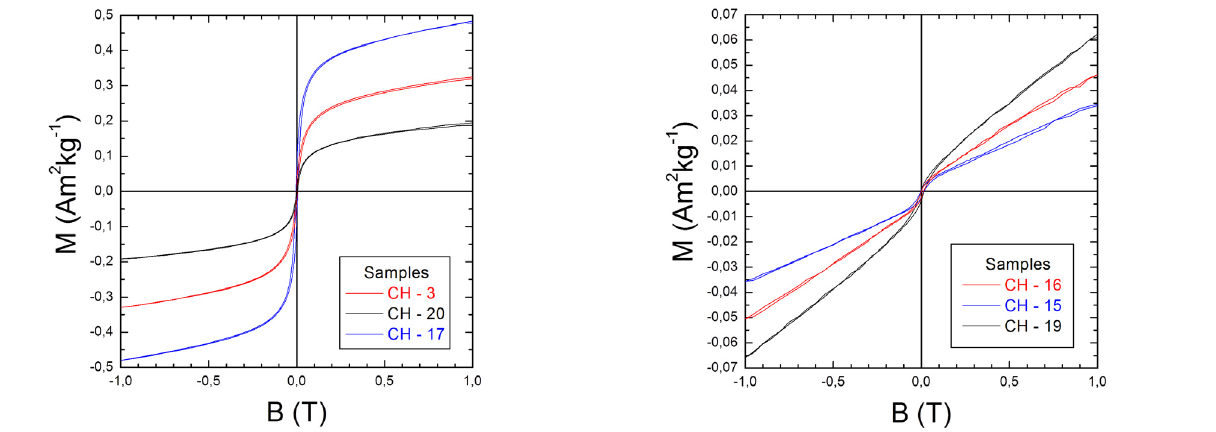
Figure 2. Hysteresis cycles for representative samples. Two main groups are individuated according to their magnetic behavior: presence of SD and PSD plus minor superparamagnetic grains (left side) and dominant paramagnetic grains plus faint SD and PSD contributions (right